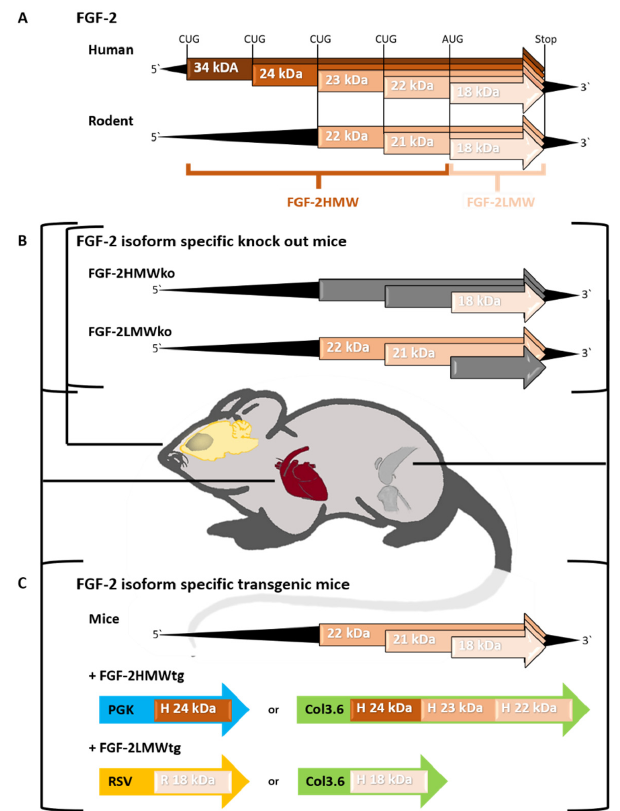
Figure 1. Endogenous FGF-2 expression and generation of FGF-2 isoform-specific mice. ( A ), based on one mRNA, translation from different CUG codons results in a 22, 23, 24, and 34 kDa product in humans summarized as FGF-2HMW. Meanwhile only the 21 and 22 kDa protein are present in rodents. Additionally, translation initiated at the AUG codon leads to expression of the 18 kDa FGF-2 isoform indicated as FGF-2LMW. ( B ), FGF-2 isoform-specific ko mice were created by gene targeting resulting in FGF-2HMWko mice, only expressing FGF-2LMW and vice versa FGF-2LMWko mice which only possess FGF-2HMW. These mice were more closely characterized with regard to development of the central nervous system and effects in neurodegenerative disease models as well as development and functionality of the cardiovascular system, bone formation and regeneration (indicated by square brackets). ( C ), Also FGF-2 isoform-specific tg mice were generated, which overexpress specific FGF-2 isoforms in addition to endogenous FGF-2. With regard to the cardiovascular system FGF-2HMWtg mice overexpressing the human 24 kDa FGF-2 isoform driven by the PGK were analyzed as well as FGF-2LMWtg mice overexpressing the rat FGF-2LMW protein using the RSV promoter. In opposition to that, bone physiology was characterized in FGF-2HMWtg mice additional possessing the human 22, 23, and 24 kDa FGF-2 isoform using the Col3.6 promoter, which also drives human FGF-2LMW isoform expression in FGF-2LMWtg mice. Col3.6, collagen 3.6 promoter; FGF-2, fibroblast growth factor 2; H, human; HMW, high molecular weight; kDA, kilo Dalton; ko, knock out; LWW, low molecular weight; PKC, protein kinase C; R, rat; RSV, Rous sarcoma virus long terminal repeat; tg,